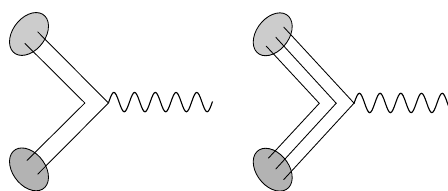
Figure 3 . We sketch the vertexes of composite boson (left) and fermion (right) interacting with SM gauge bosons (wave line), and the SM elementary fermion is represented by a solid line. In general, these vertexes should be understood as one-particle-irreducible vertexes of SM gauge bosons interacting with the entire composite particle as an elementary particle. At the lowest tree-level order of perturbative SM gauge couplings, the vertexes can be represented by the sum of possible gauge couplings to an SM elementary particle inside a composite particle. Note that we do not show the vertexes of composite boson (left) interacting with two SM gauge bosons that are present in the effective Lagrangian